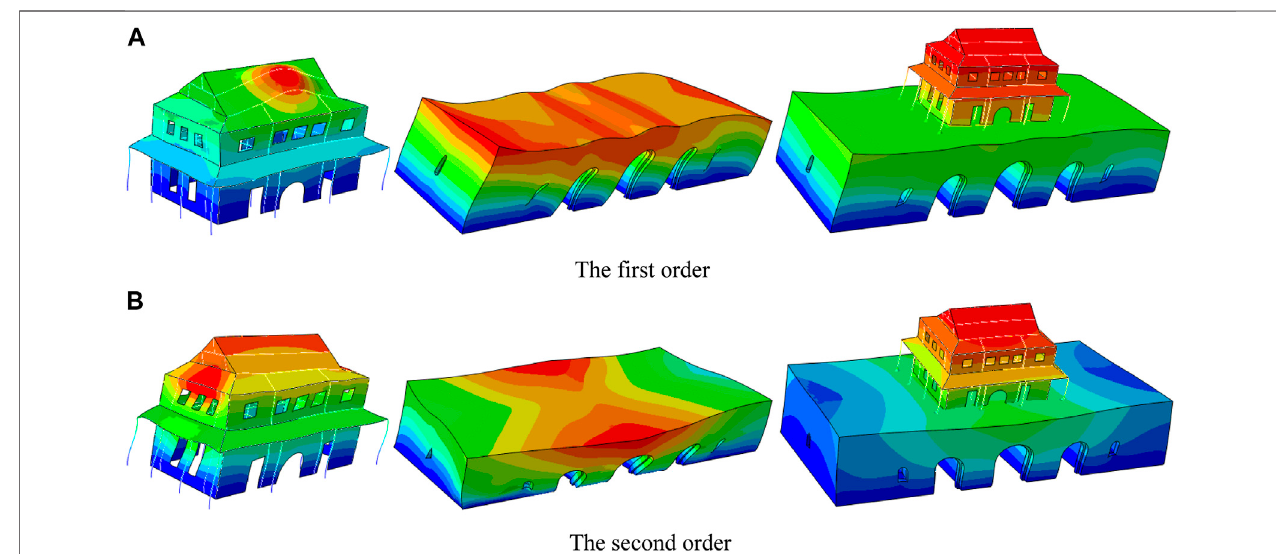
FIGURE 5 | Vibration modes of the Drum Tower model. (A) The fi rst order. (B) The second order.